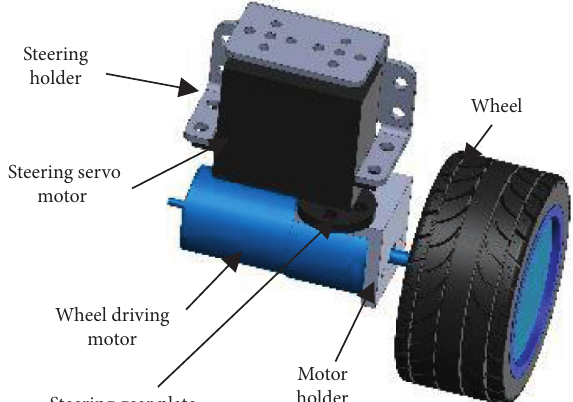
Figure 2: Wheel system